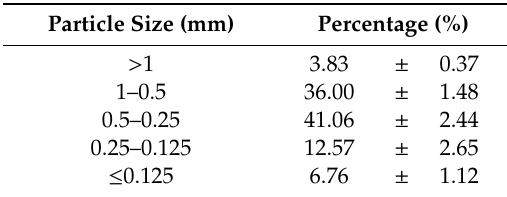
Table 2. Particle size distribution.